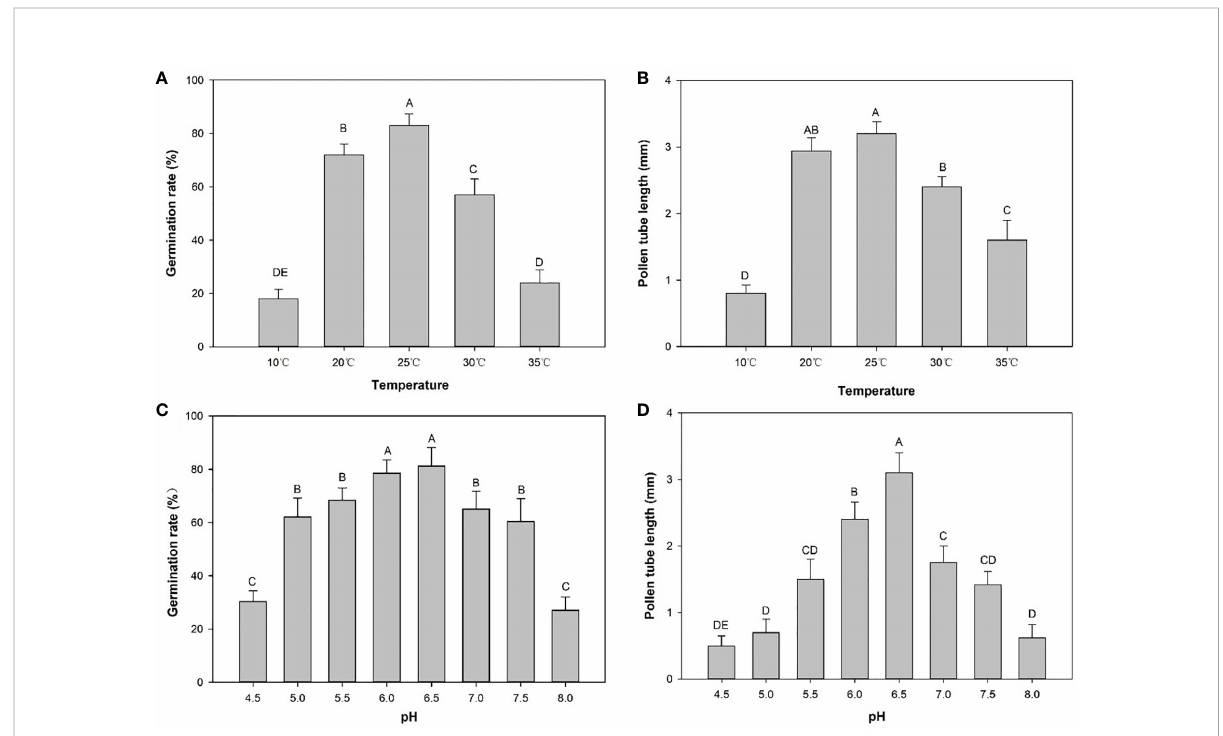
FIGURE 4 Germination rates (%) and pollen tube length (mm) in CK2 medium at different temperatures or pH values. (A) Germination rates at different temperatures. (B) Pollen tube lengths at different temperatures. (C) Germination rates at different pH values. (D) Pollen tube lengths at different temperatures. Distinct letters point out the statistically signi fi cant differences ( P < 0.01) and error bars indicate the standard